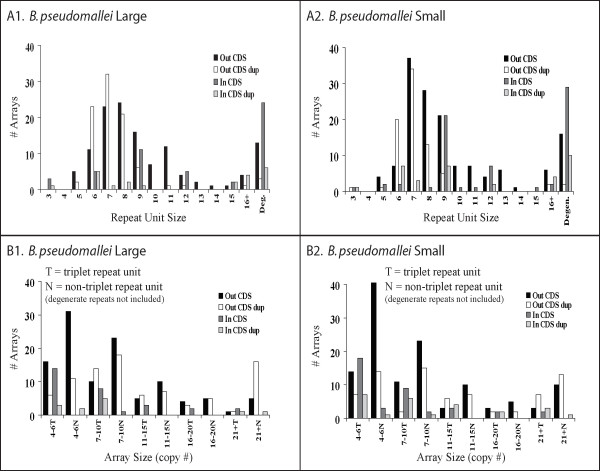
Repeat region motif size and total array size distribution. A) Frequencies of arrays consisting of different size repeat motifs in inter-, intragenic and duplicated locations. Degenerate repeats were determined as described in the Materials and Methods Section. B) Frequencies of arrays consisting of different total size classes, again in inter-, intragenic and duplicated locations, based upon triplet and non-triplet repeat motif copy number. Degenerate arrays are not included as consensus repeat motifs were not determined.